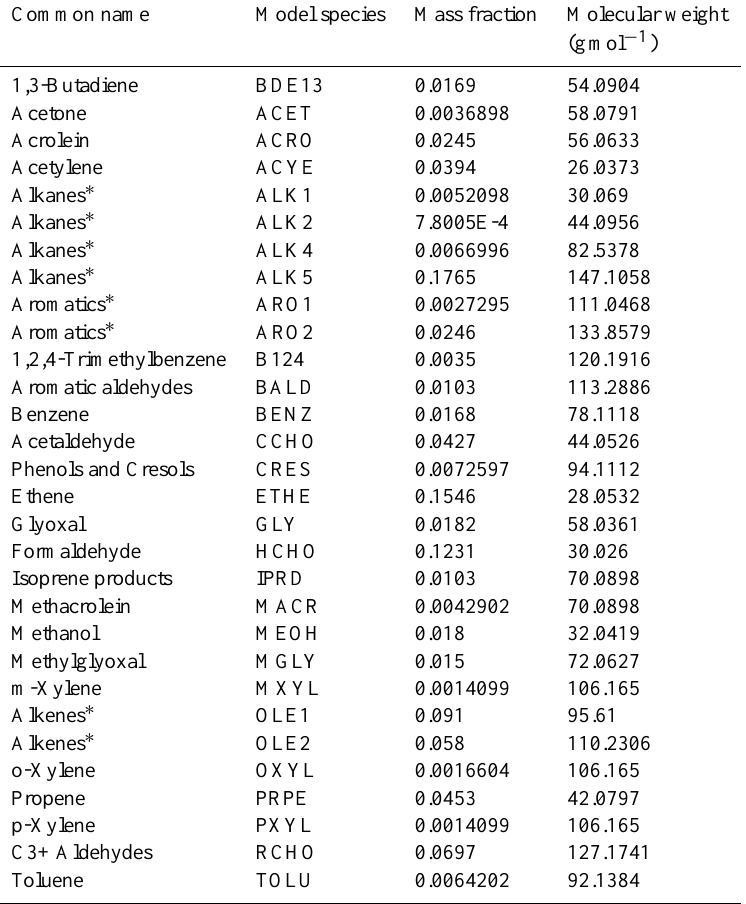
Table 2. SPECIATE v4.3 speciation profile 5565B used to speciate aircraft TOG emissions to SAPRC-07 model species.